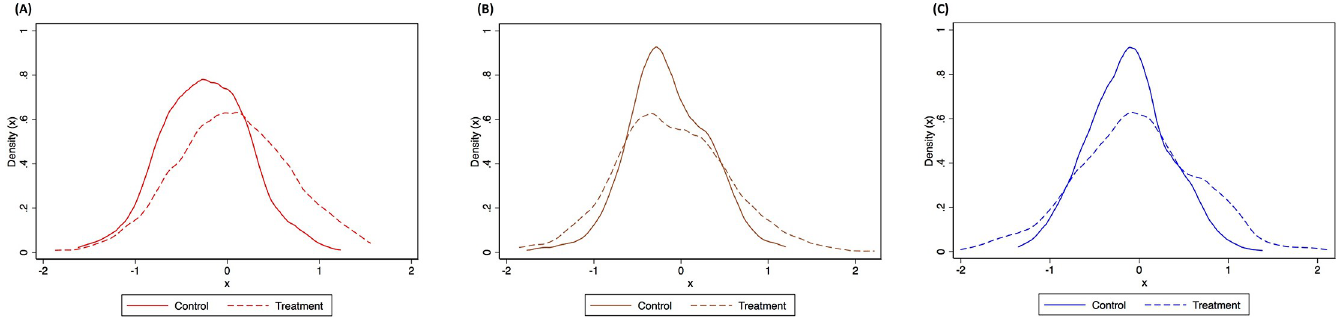
Fig 3. Density distribution of individual WTP coefficients (x) for the control and treatment groups. (a) For Wild. (b) For Hormones. (c) For Triploid.